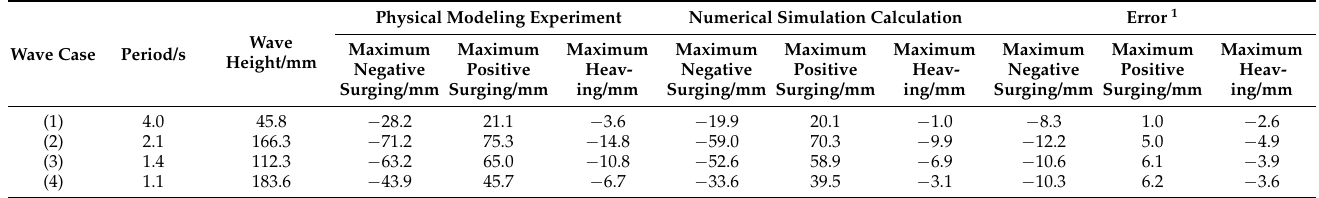
Table 3. Parameters of wave cases and experiment results